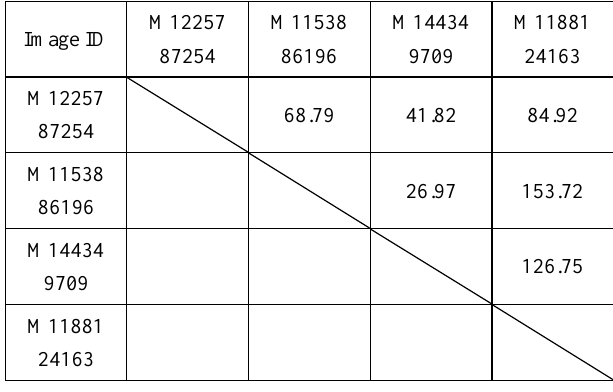
Table 3. Illumination azimuthal difference of image pairs in